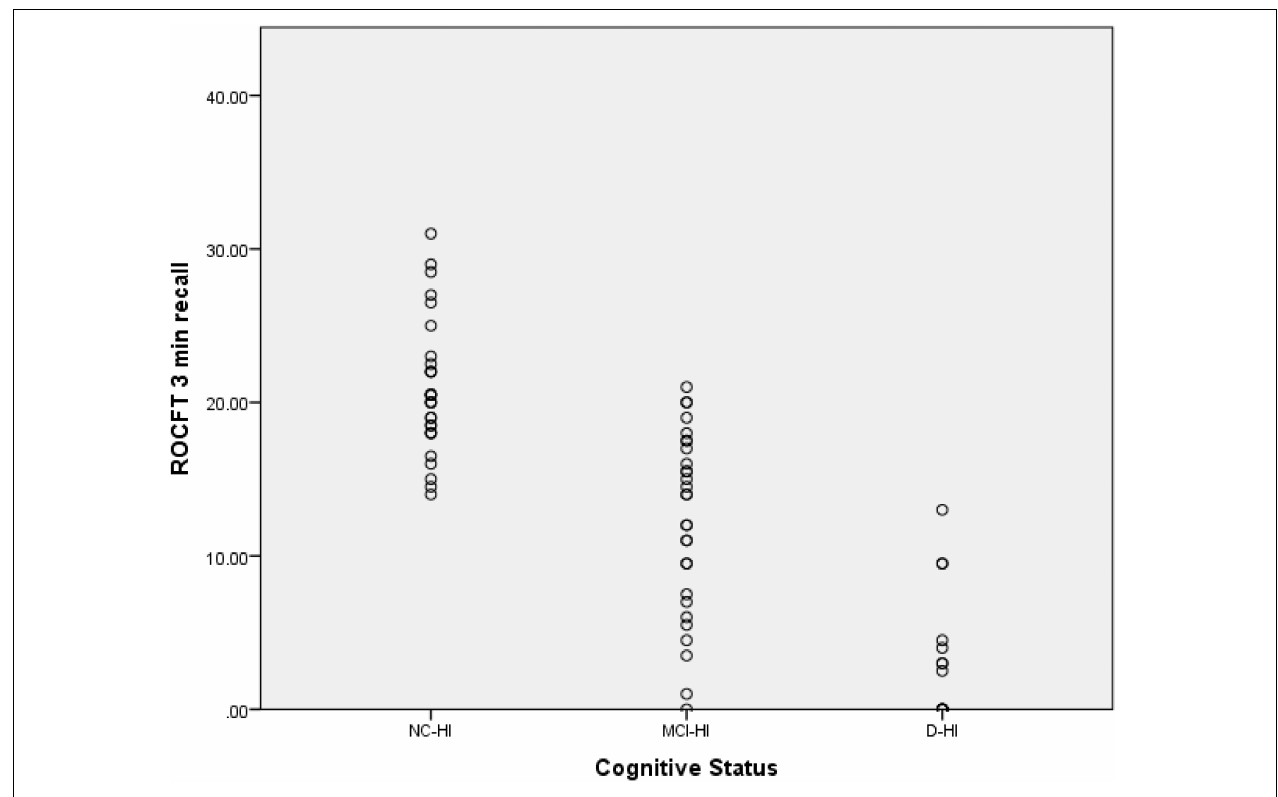
FIGURE 2 | Scatter plot for the ROCFT 3 min recall scores of the three